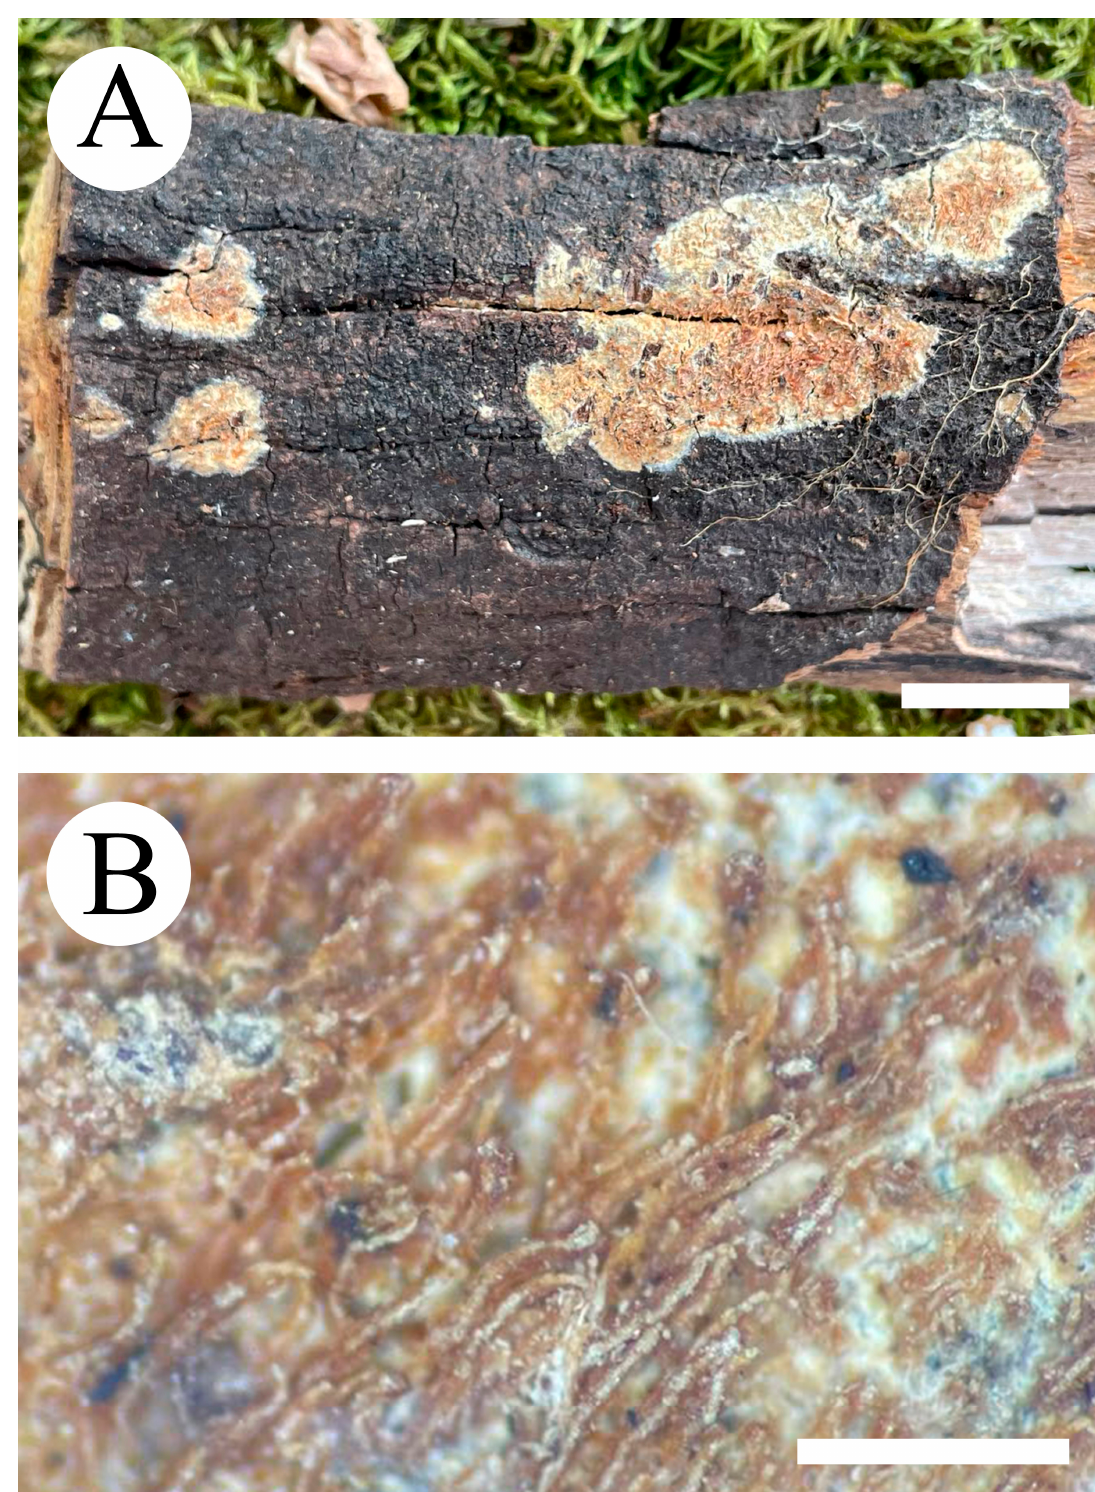
Figure 11. Basidioma of Mycoaciella brunneospina (CLZhao 15876, holotype). Bars: ( A ) = 1 cm, ( B ) = 1 mm.